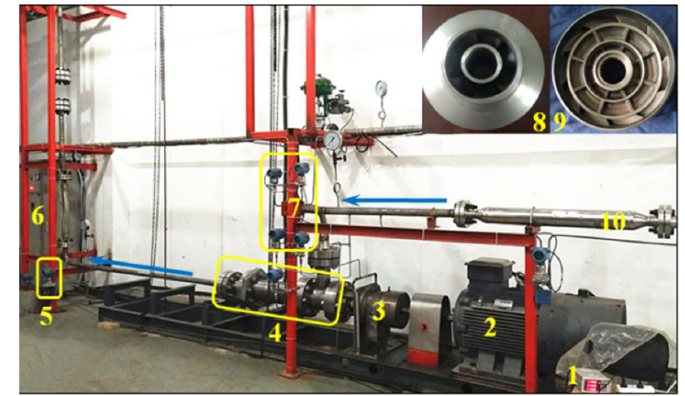
Figure 16. Site layout of the multiphase pump test bed. ( 1 ) Torque and speed displayer, ( 2 ) Electric motor, ( 3 ) Bearing housing, ( 4 ) Multiphase pump test section, ( 5 ) Differential pressure sensor, ( 6 ) Frequency converter control cabinet, ( 7 ) Pressure sensor, ( 8 ) Impeller, ( 9 ) Diffuser, ( 10 ) Mixer.